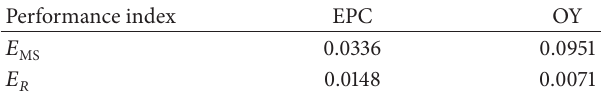
Table 3: MSE and RE of GRNN